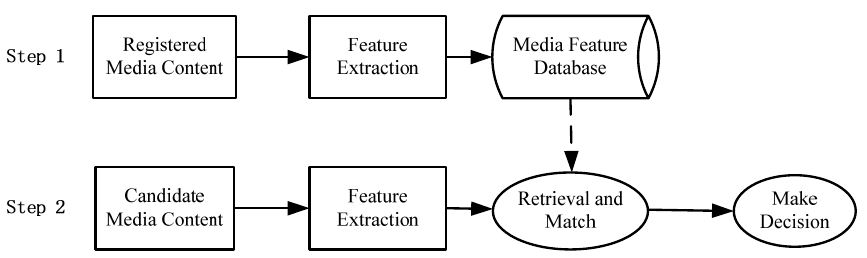
Fig. 1 The automatic content review mechanism of the